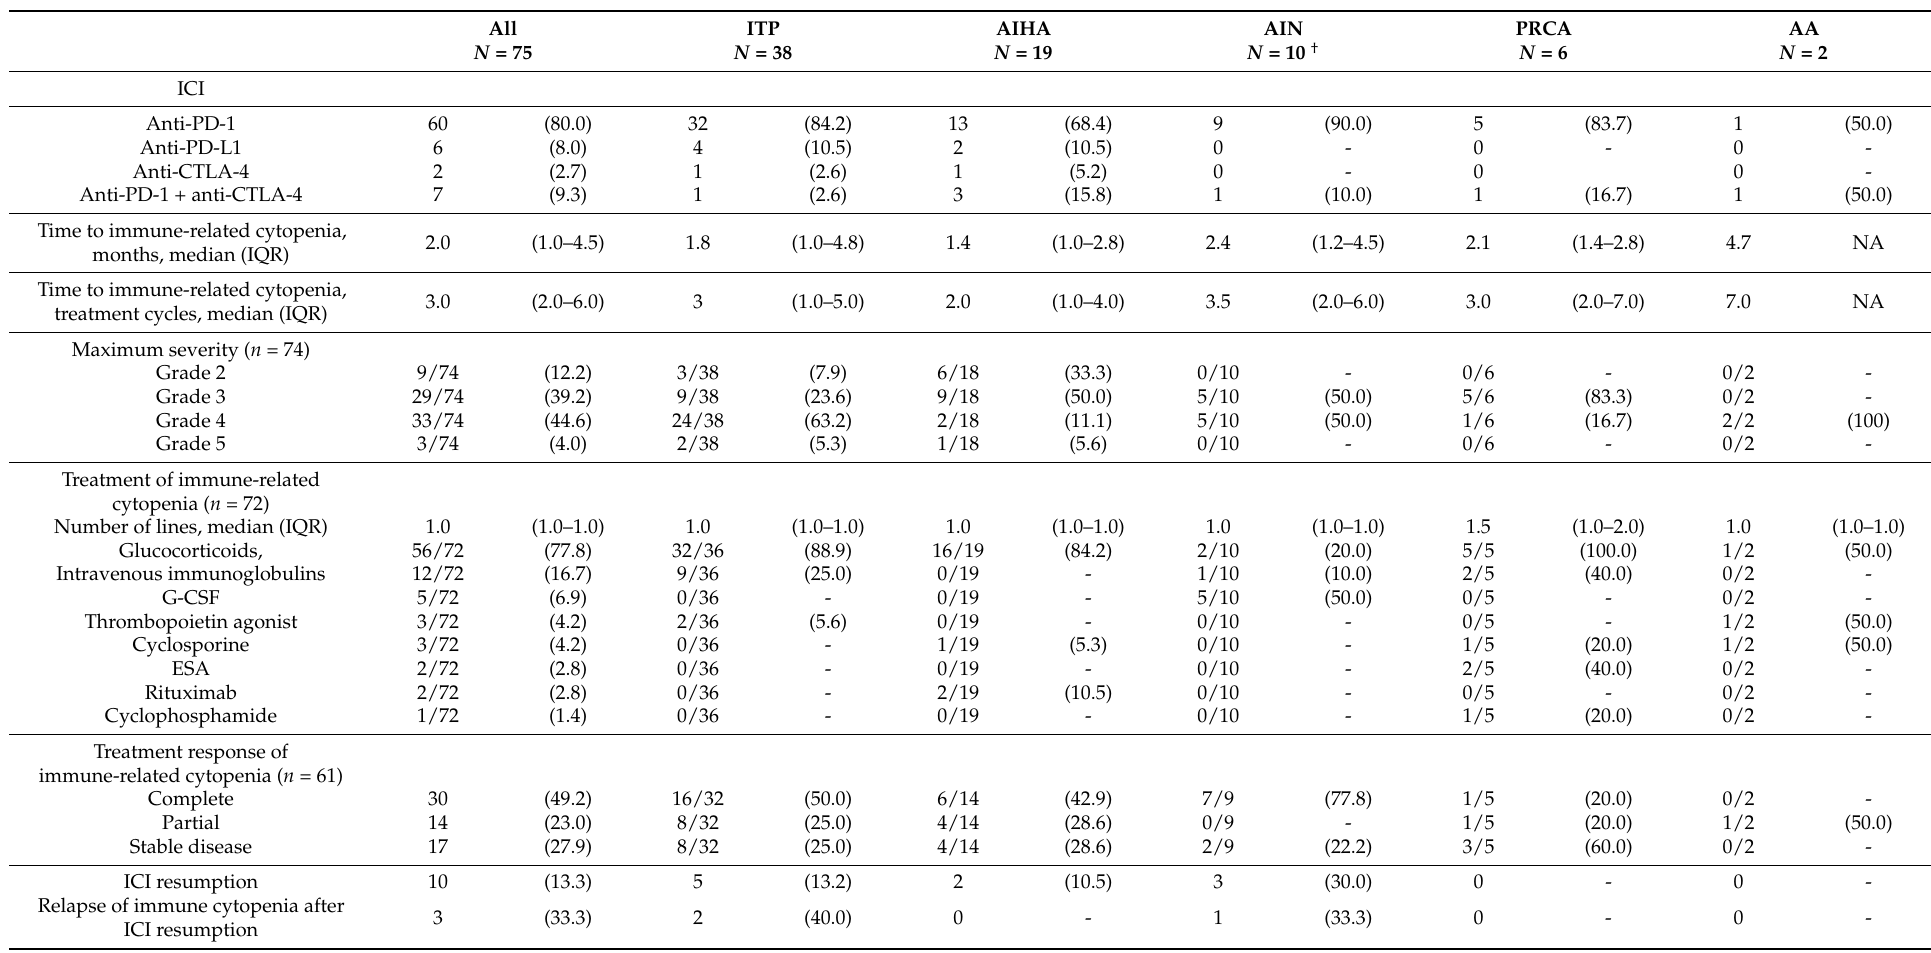
Table 2. Characteristics of ICI-related